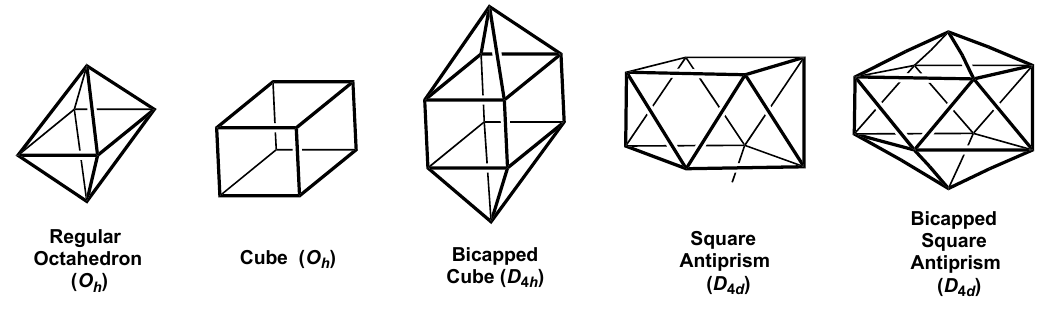
Figure 3. Tetragonal polyhedra with at least one C 4 rotation axis.